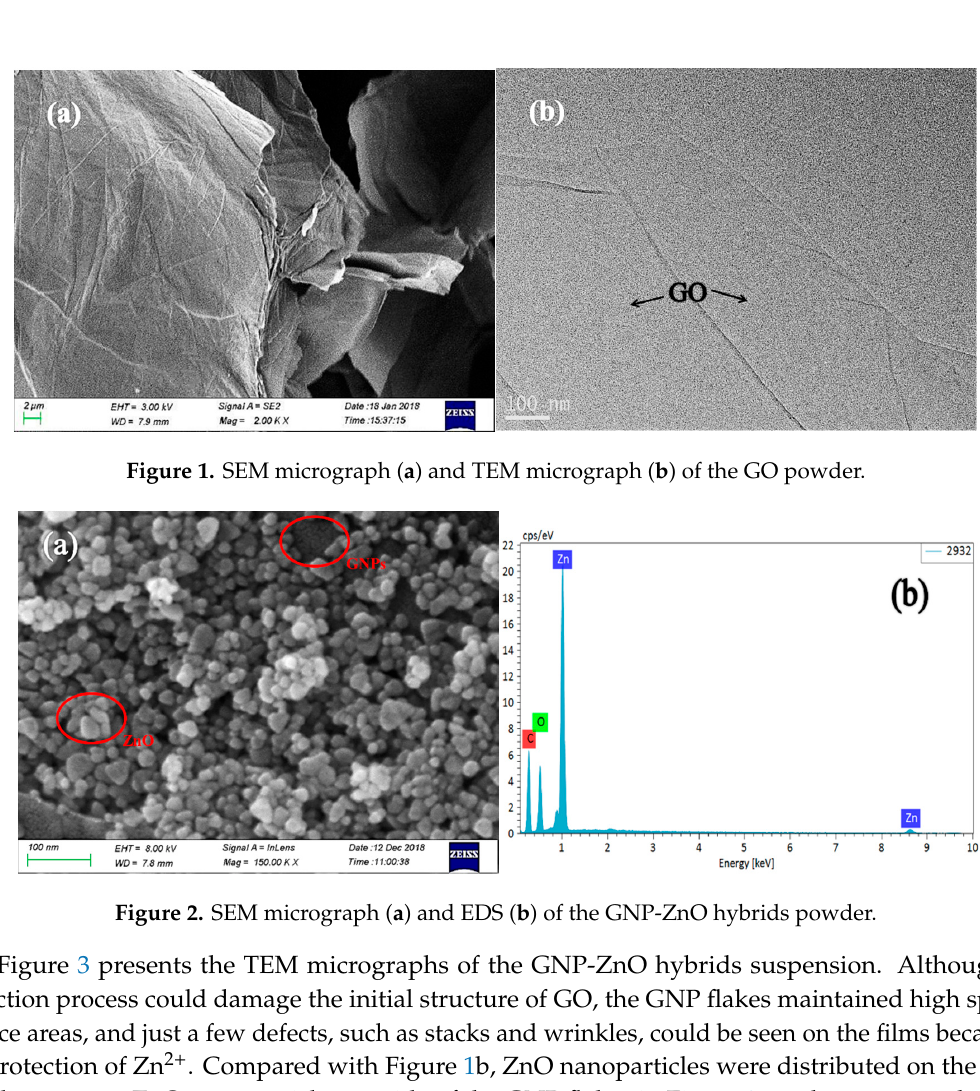
Figure 1. SEM micrograph ( a ) and TEM micrograph ( b ) of the GO powder.